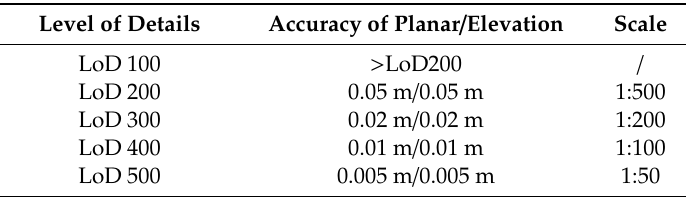
Table 2. The description and accuracy of the level of